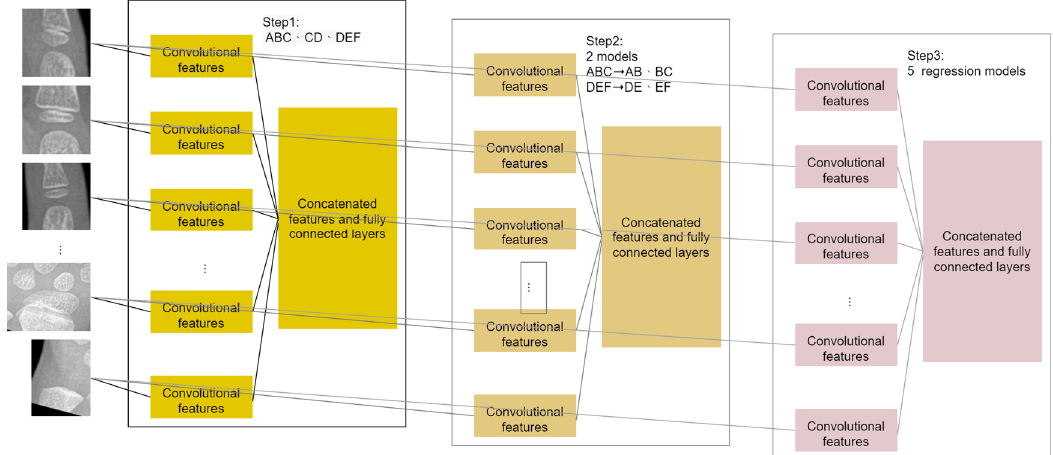
Figure 3. Framework of the MSCS-CNN.